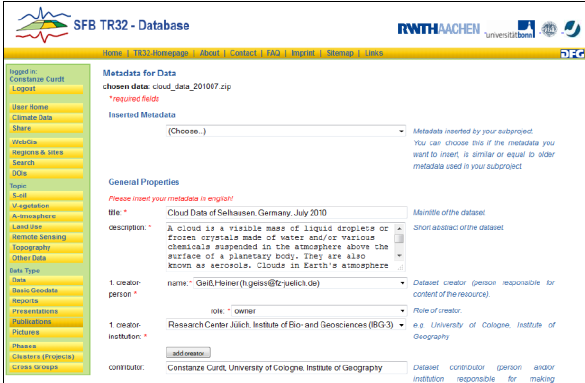
Figure 3. Metadata input form for data type